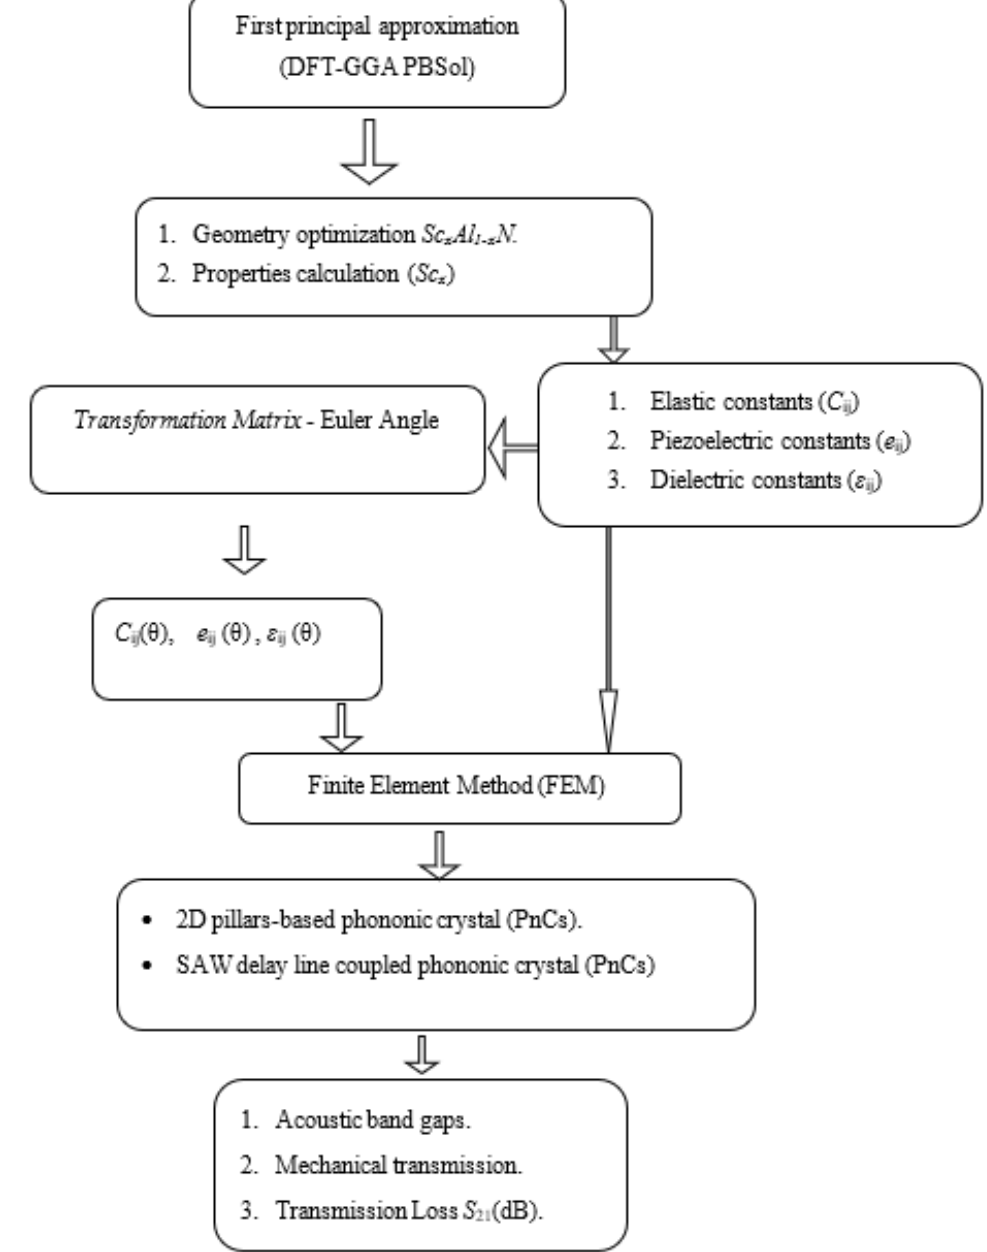
Figure 1. Diagram of the calculation methodology.